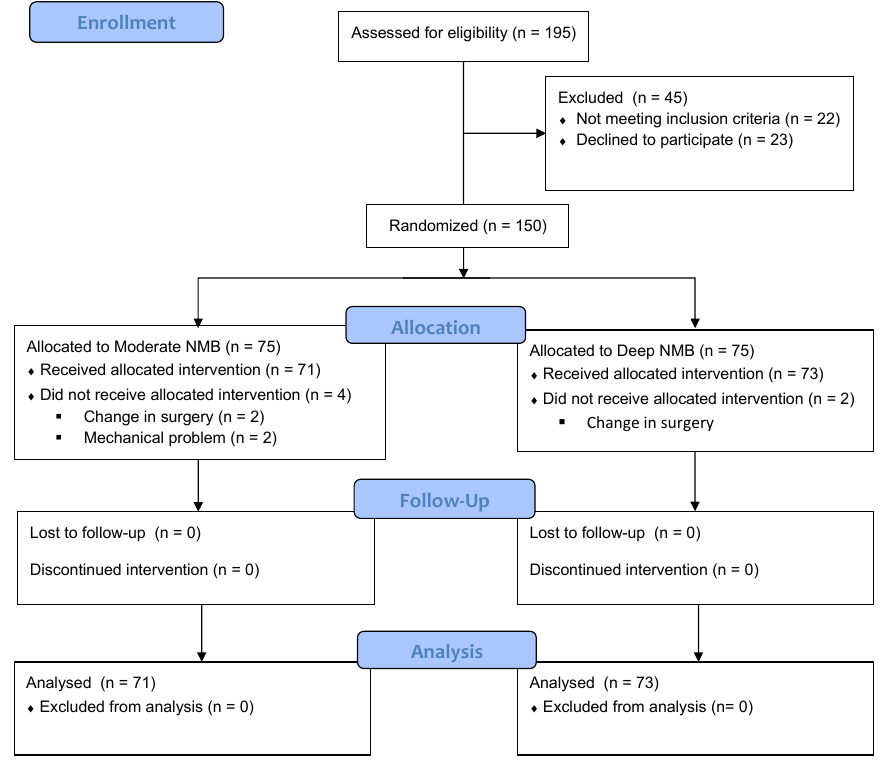
Figure 1. CONSORT flow chart. Table 1. Patient demographic characteristics and surgical